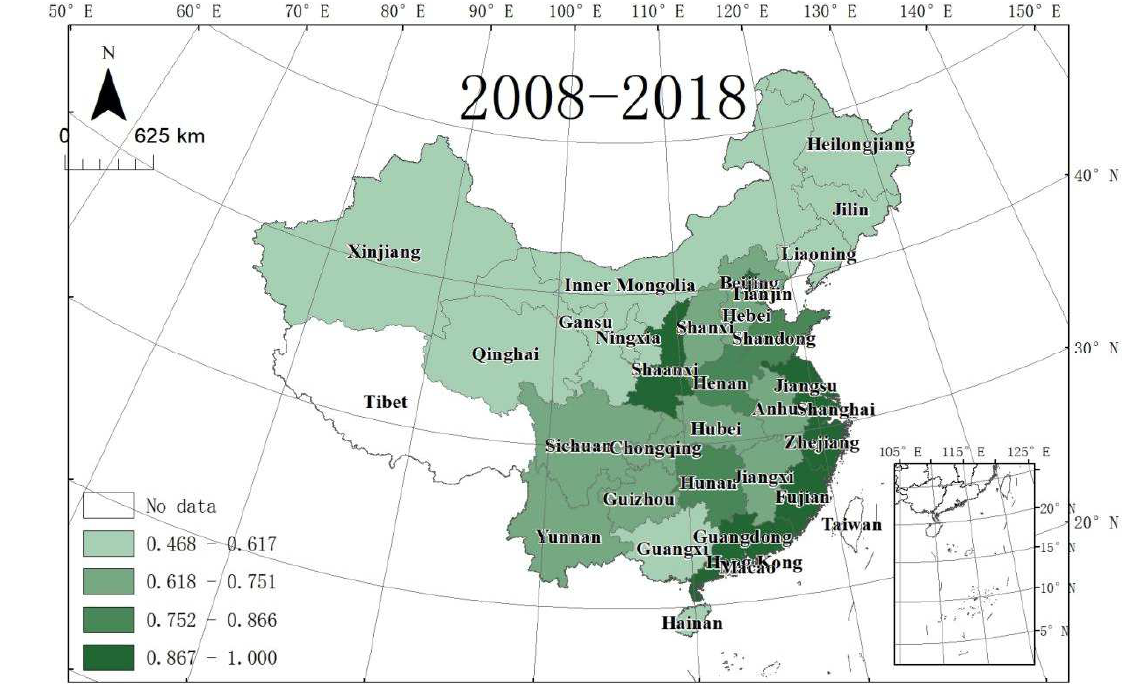
Figure 3. Average ULGLE values in 30 Chinese provinces (2008–2018).